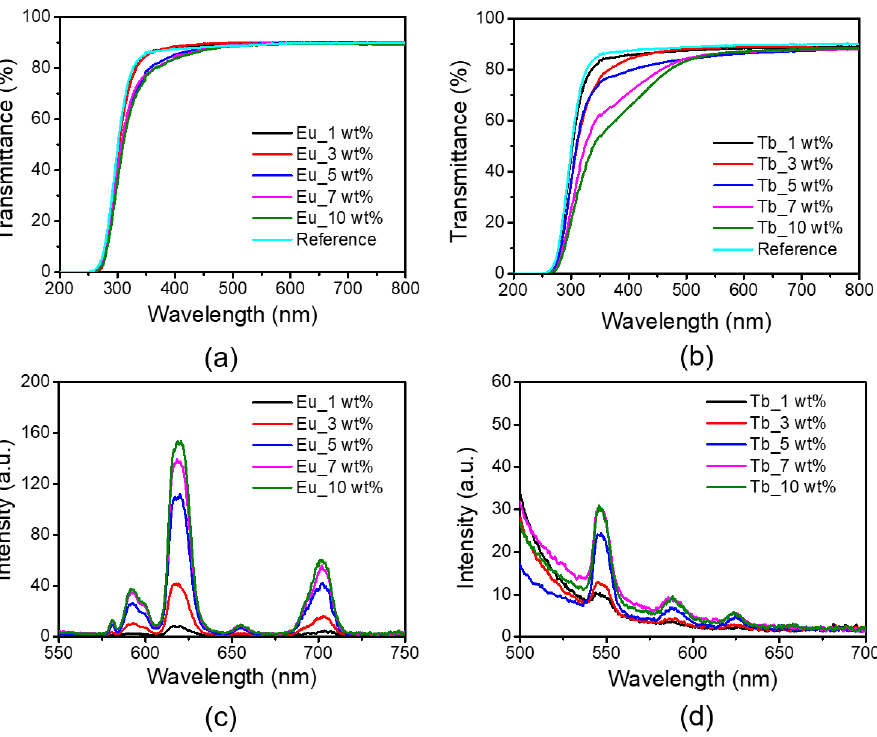
Figure 4. UV–Vis transmittance spectra of ( a ) LPGSQ64–Eu and ( b ) LPGSQ64–Tb films with different doping concentrations; PL luminescence spectra of ( c ) LPGSQ64–Eu and ( d ) LPGSQ64–Tb films with different doping concentrations.